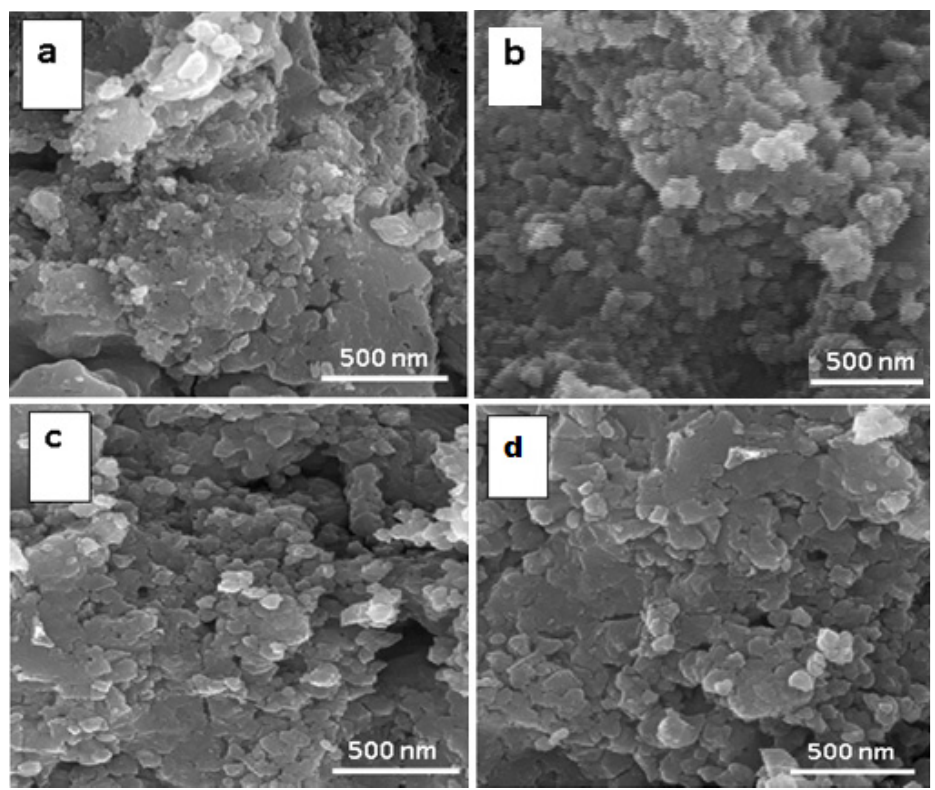
Figure 5. HR-SEM images of ( a ) MnFe 2 O 4 , ( b ) MnCe 0.1 Fe 1.9 O 4 , ( c ) MnCe 0.3 Fe 1.7 O 4 and ( d ) Crystals 2022 , 12 , x FOR PEER REVIEW Figure 5. MnCe 0.5 Fe 1.5 O 4 NCs. ( d ) MnCe 0.5 Fe 1.5 O 4 NCs.